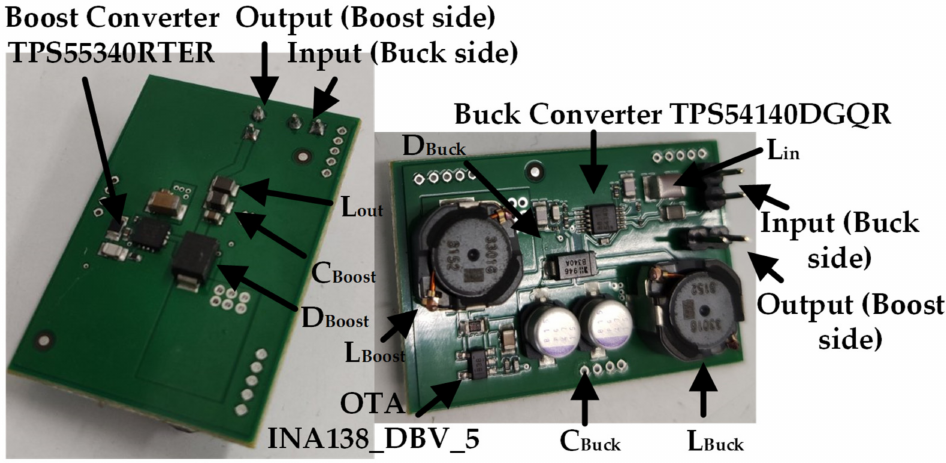
Figure A1. Novel energy recovery unit. Package dimensions: height: 10 mm, width: 39 mm, length: 27 mm.